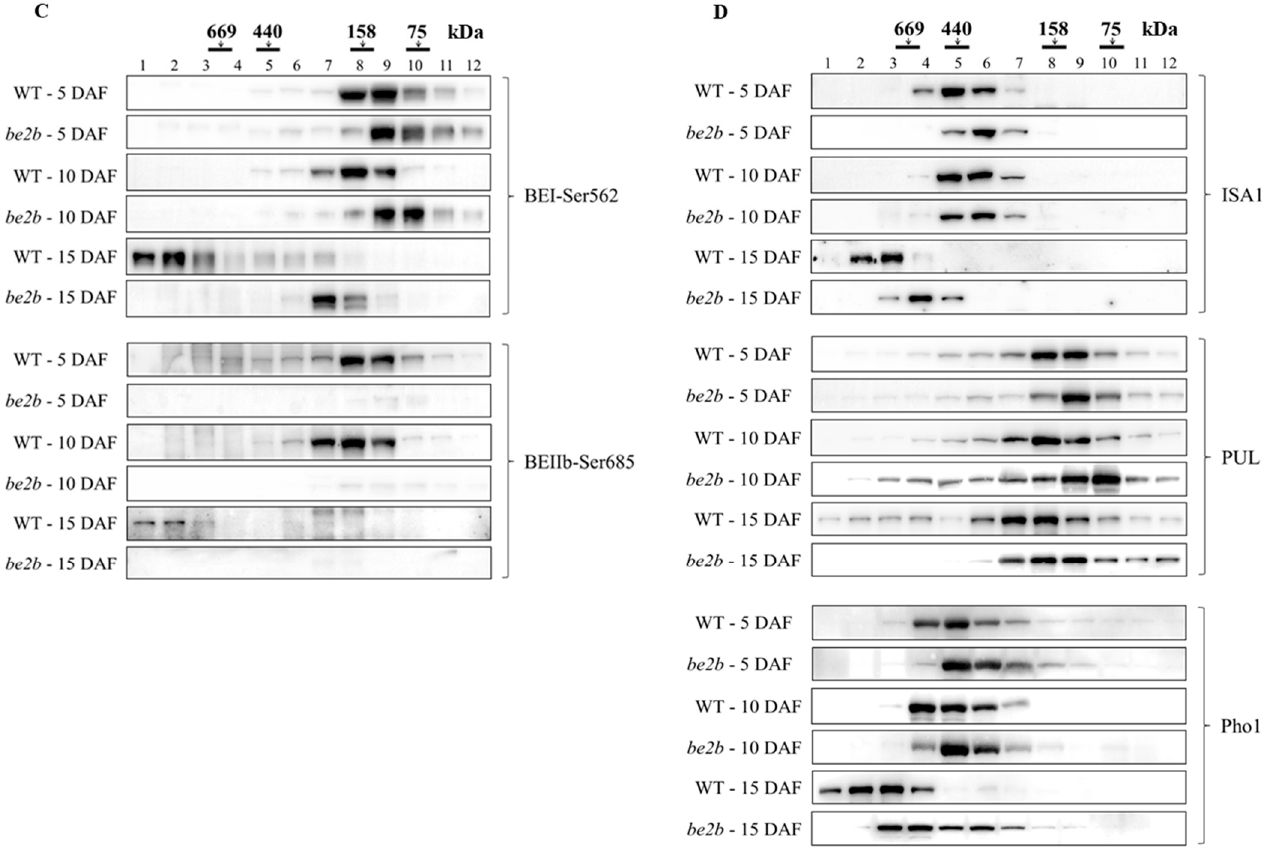
Figure 2. Molecular weight distributions of SSREs during different grain-filling stages (5 DAF, 10 DAF, 15 DAF) in wild type (WT) and be2b mutant. Fractions 1–12 obtained after gel filtration chromatography of soluble proteins extracted from the developing seeds were separated by SDS- PAGE prior to Western blotting with indicated isozyme-specific antibodies. Each lane was loaded with 5 µ L of 10-fold concentrated fractions. The molecular weight of protein standards is shown at the top (black bars): ( A ) Western blotting of SS isozymes. ( B ) Western blotting of BE isozymes. ( C ) Western blotting of phosphor BE isozymes. ( D ) Western blotting of DBE isozymes and